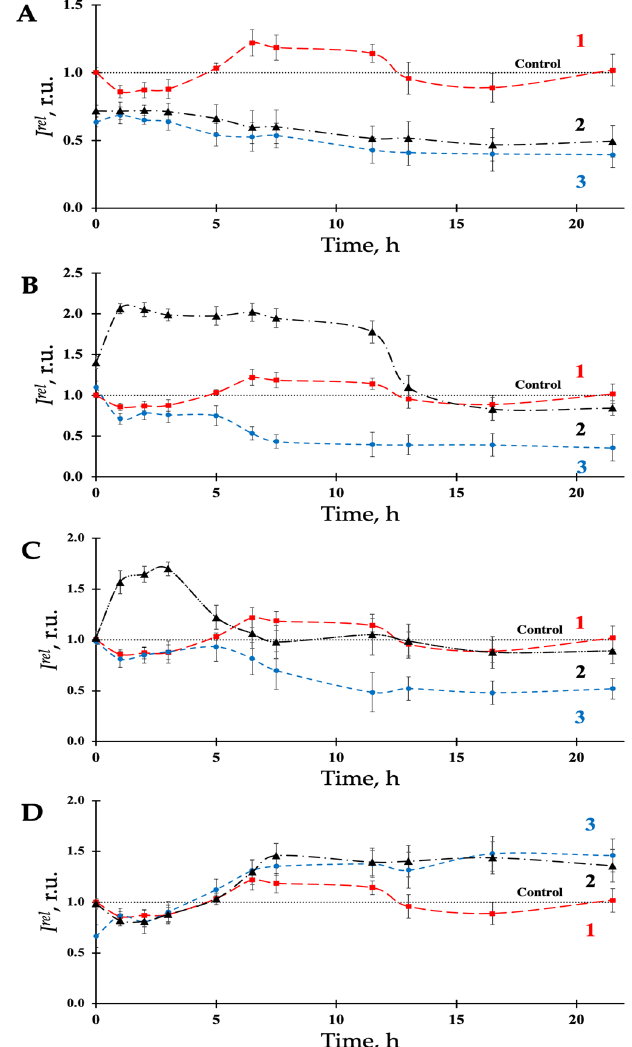
Figure 2. Bioluminescence intensity, I rel , in bacterial suspensions in the presence of HTO (2 MBq/L) and/or AuNPs of different concentrations (colored curves): ( 1 ) HTO, ( 2 ) AuNPs, ( 3 ) AuNPs + HTO, 2 MBq/L. Concentrations of AuNPs: ( A )—10 − 3 g/L, ( B )—10 − 4 g/L, ( C )—10 − 5 g/L, ( D )—10 − 6 g/L.3.3. Effects of AuNPs on Bacterial Bioluminescence and ROS Content. Figure 2 highlights the individual and combined effects of HTO and AuNPs on bacterial luminescence. Several concentrations of AuNPs were applied (Figure